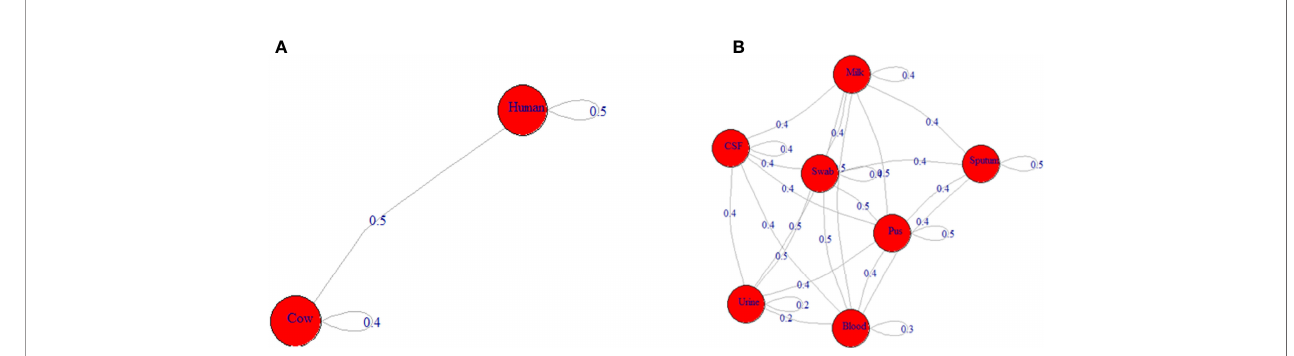
FIGURE 2 | Network depicting the differences among ST239-MRSA strains based on the antimicrobial resistance pro fi le. (A) The average distance among strains from humans and cows. (B) The average distance among strains from various